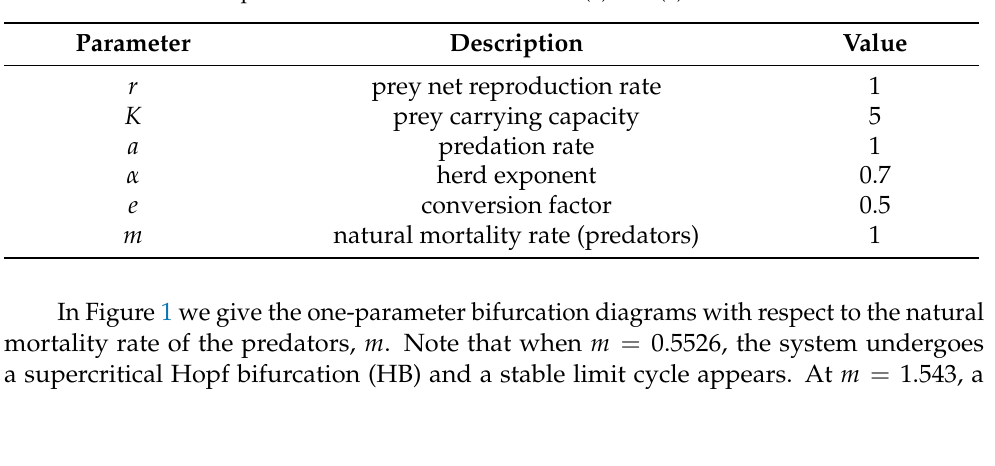
Table 6. Nominal set of parameter values for the model in (6) and